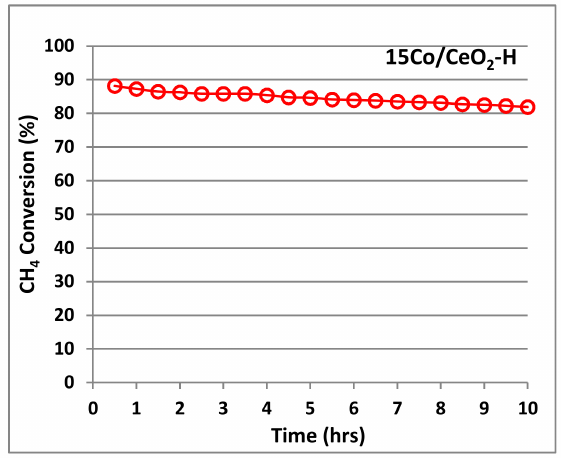
Figure 7. Response of CH 4 combustion to long-term stability tests over the optimum selected 15Co/CeO 2 -H catalyst; Flow rate: 900 cm 3 /min; GHSV~40,000 h − 1 .; Reaction temperature 600 ◦ C; Feed:. 0.5% vol. CH 4 and 10% vol. O 2 , balanced with